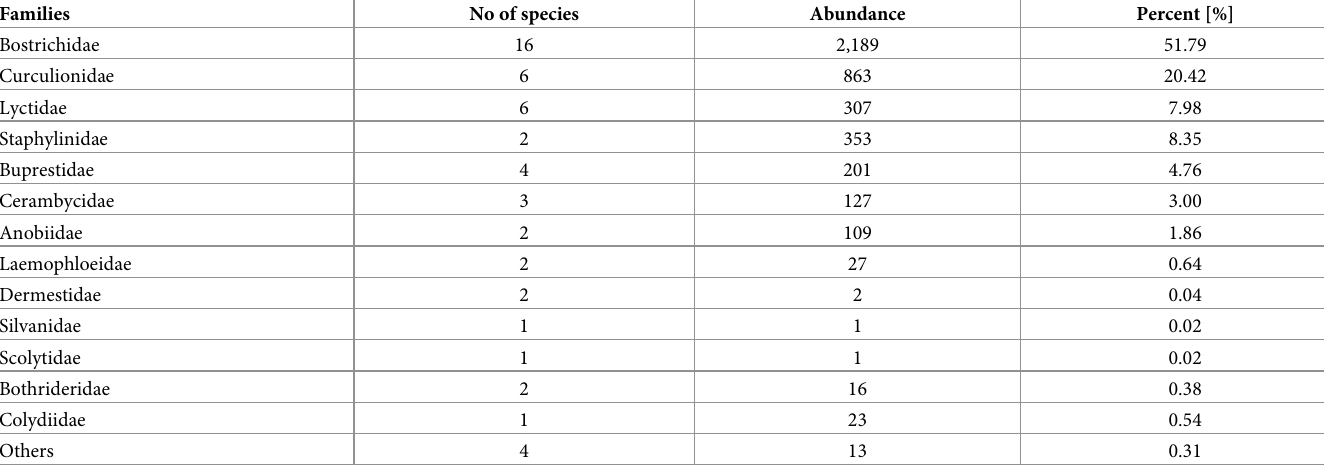
Table 2. Wood-boring beetle families recovered from Acacia xanthophloea (cid:3) at Kenyatta University between May 2016–Feb 2017.